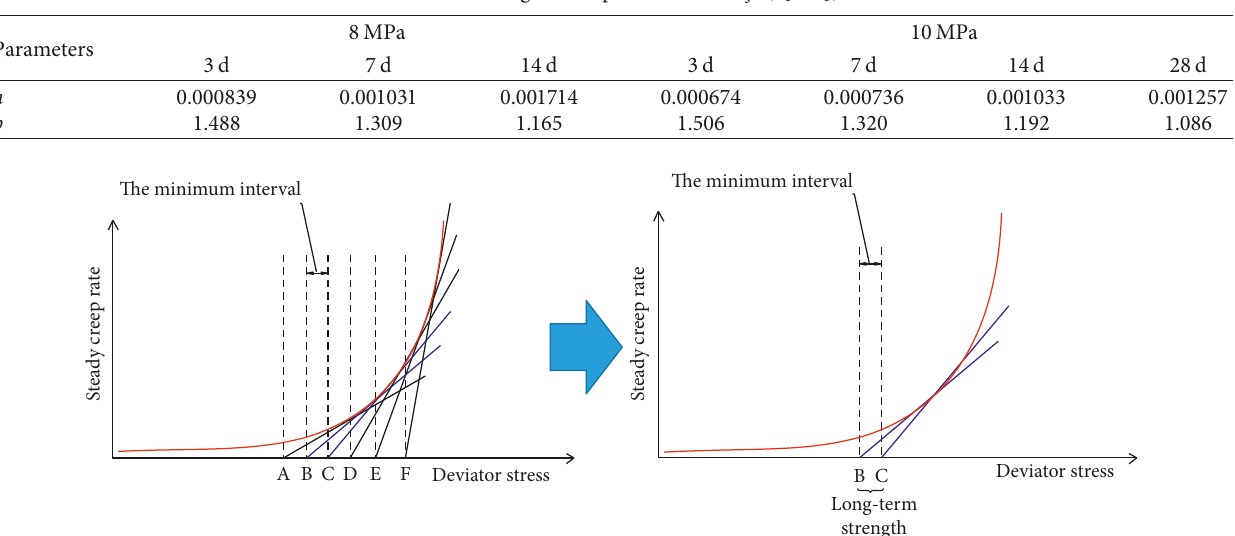
Table 4: The regression parameters of _ ε